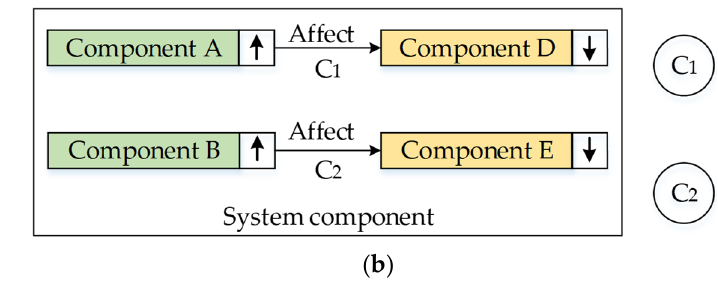
Figure 2. ( a ) The cause-effect relationship of a simple problem; ( b ) The conflict relationship of a simple problem.